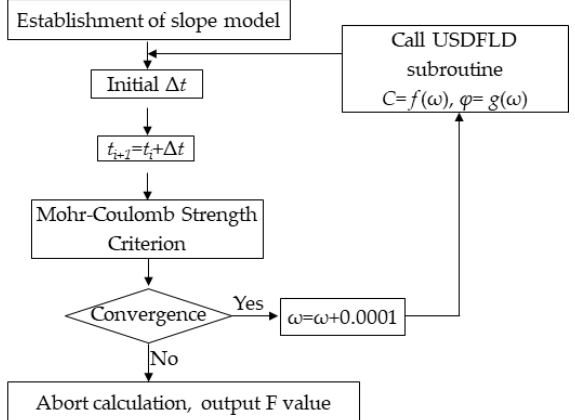
Figure 1. Flowchart of the Implementation of USDFLD Field Variable Subroutine .